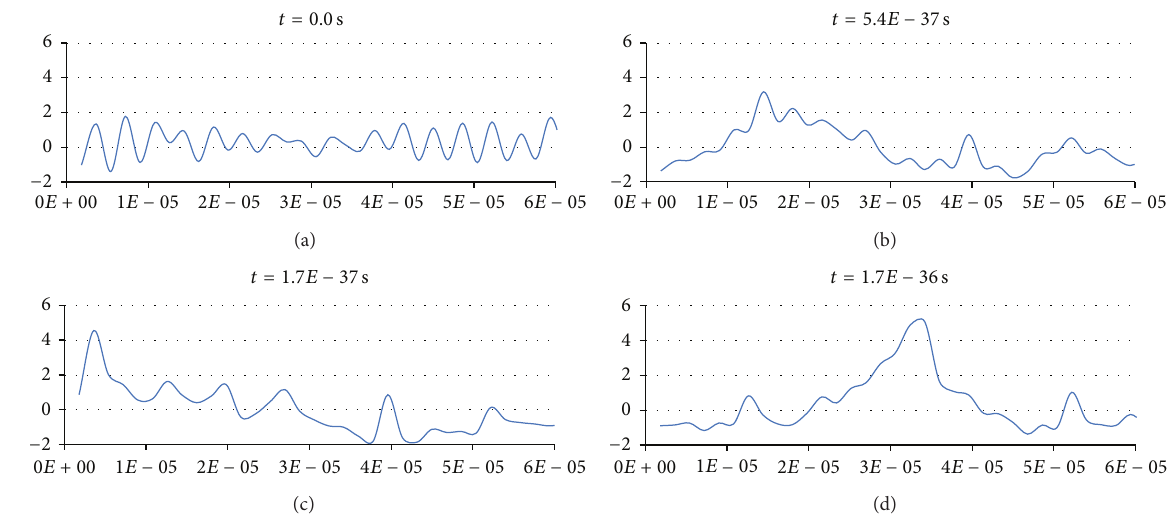
Figure 4: Power spectral density for the gauge field throughout inflation. The vertical axis is the log of the deviation from the mean. The horizontal axis is frequency in Plank